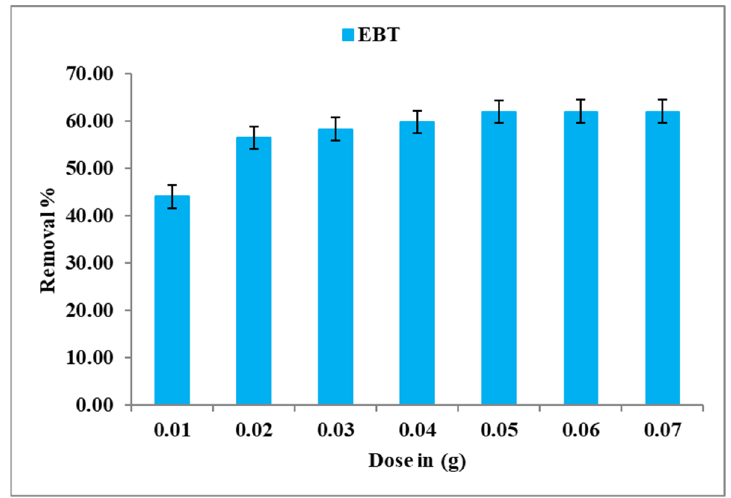
Figure 7. Influence of the mass of activated carbon of cannabis on adsorption of EBT dye (stirring speed = 150 rpm, t = 90 min, pH = 7 ± 0.2; C 0 = 10 mg.L − 1 and temperature = 20 ± 1 °C).